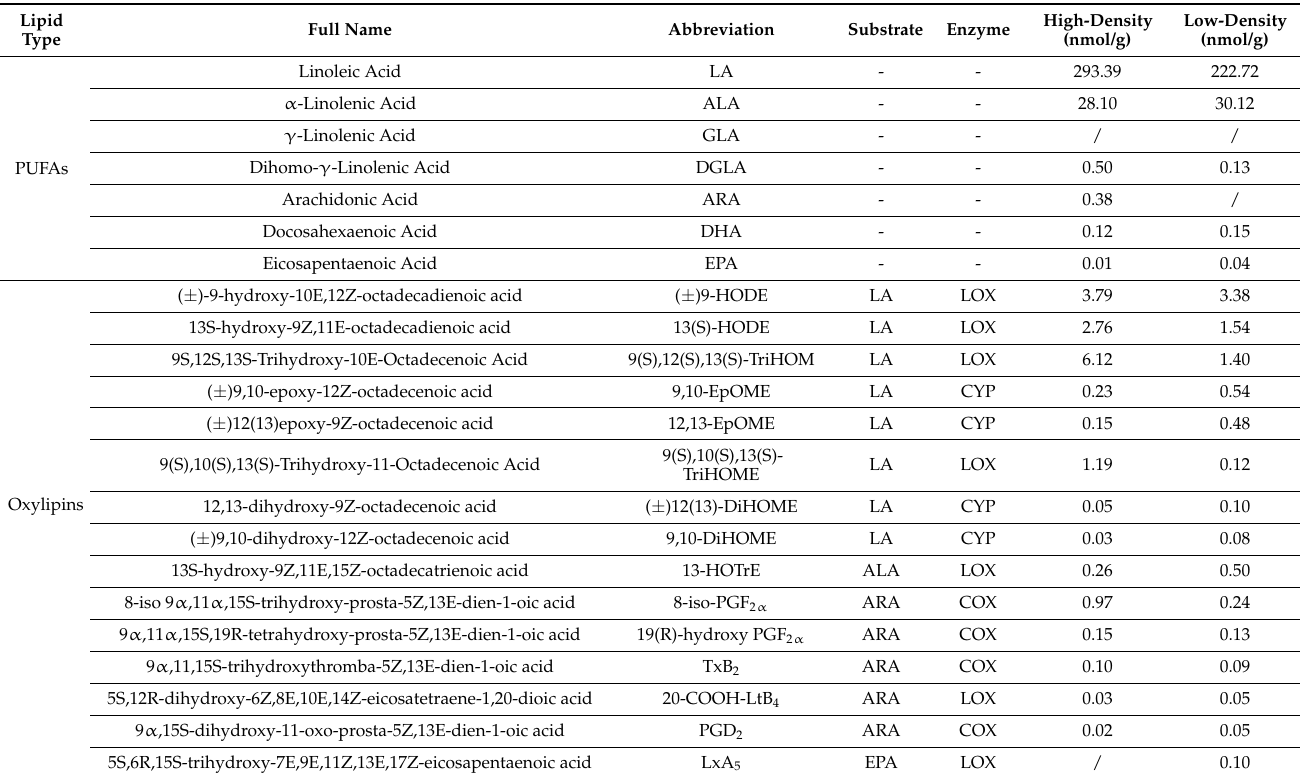
Table 1. The amount of unsaturated fatty acids and oxidized derivatives detected in the low- and high-density